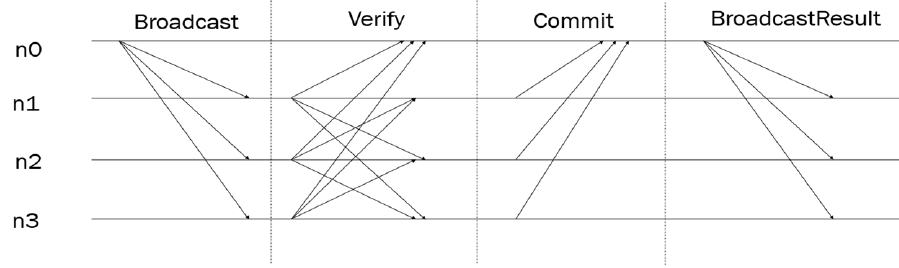
Figure 3. Node elimination consensus process.